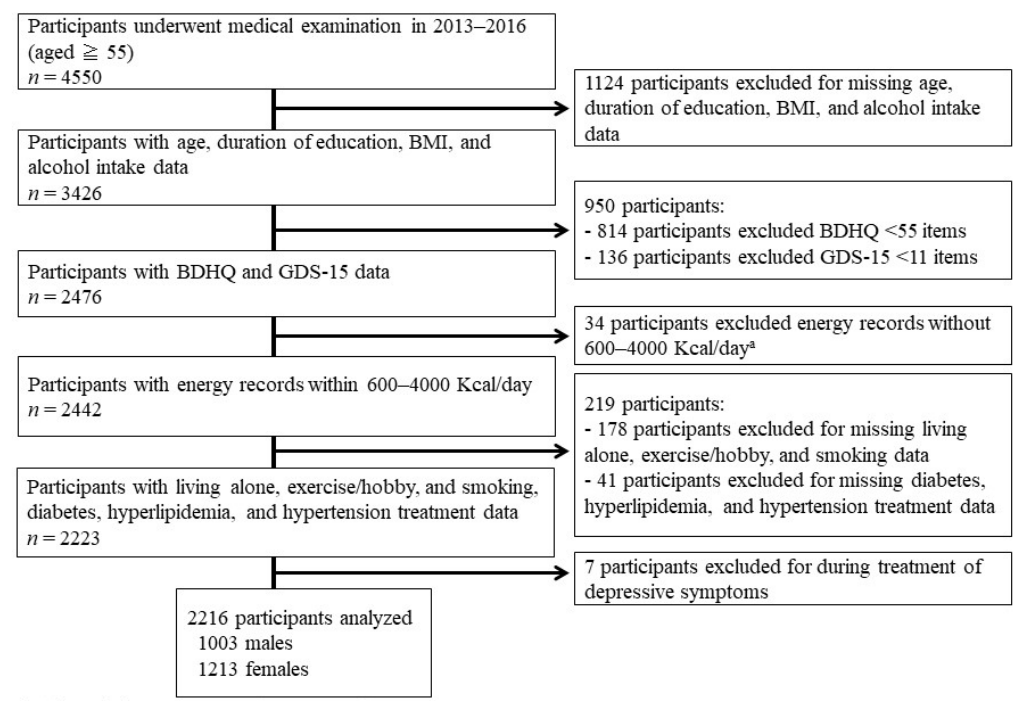
Figure 1. Participant recruitment chart. Abbreviations: BMI, Body Mass Index; BDHQ, Brief-type self-administered Diet History Questionnaire; GDS, Geriatric Depression Scale.